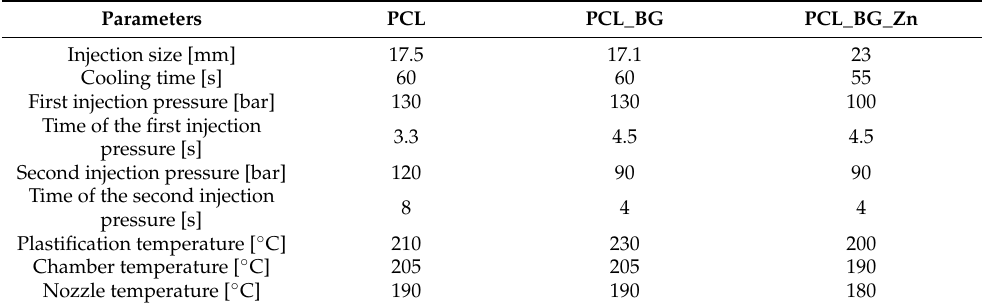
Table 1. Parameters of the injection process of PCL and PCL_BG and PCL_BG_Zn blends.